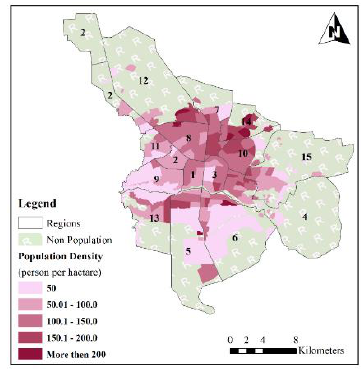
Figure2. Population density.